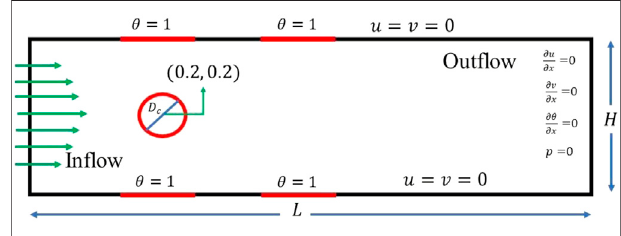
FIGURE 1 | Schematic fi gure of the fl ow